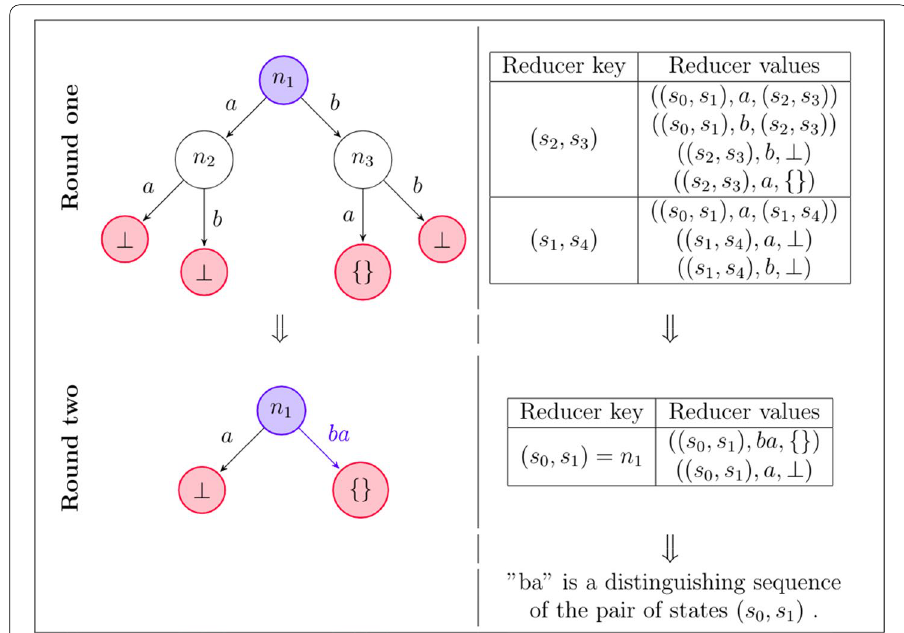
Fig. 4 The derivation step of M / s 0 ∩ M / s